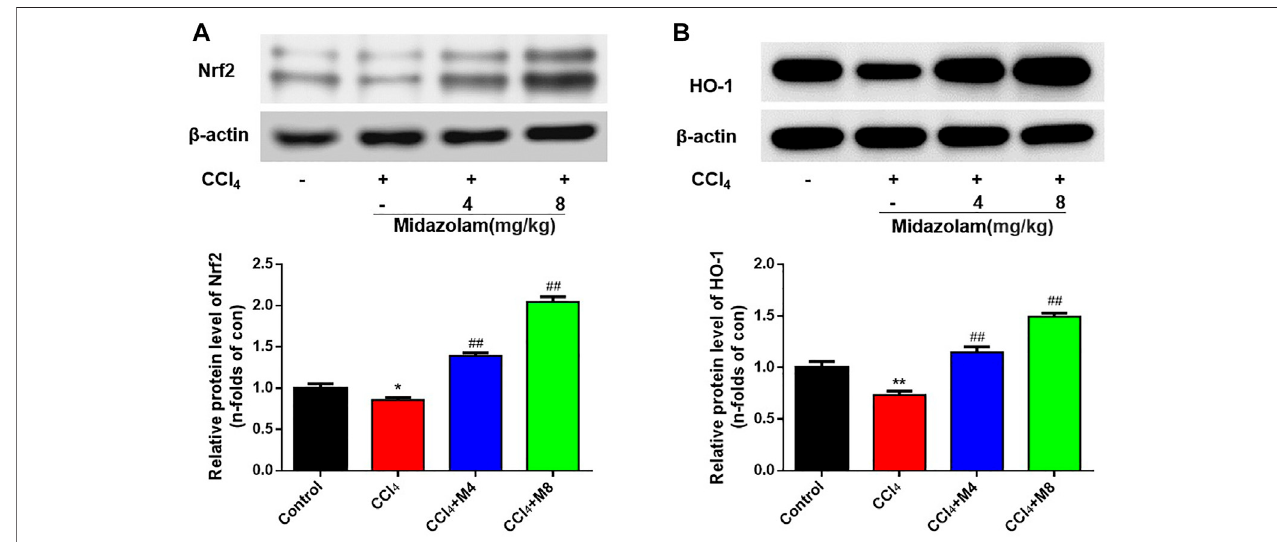
FIGURE 6 | Effect of midazolam on the expression of Nrf2 and HO-1 in mice liver. The protein levels of Nrf2 (A) and HO-1 (B) were examined at 24 h after CCl 4 exposure. ( n = 8 in each group). ** p < 0.01 vs. the control group; ## p < 0.01 vs. the CCl 4 group.